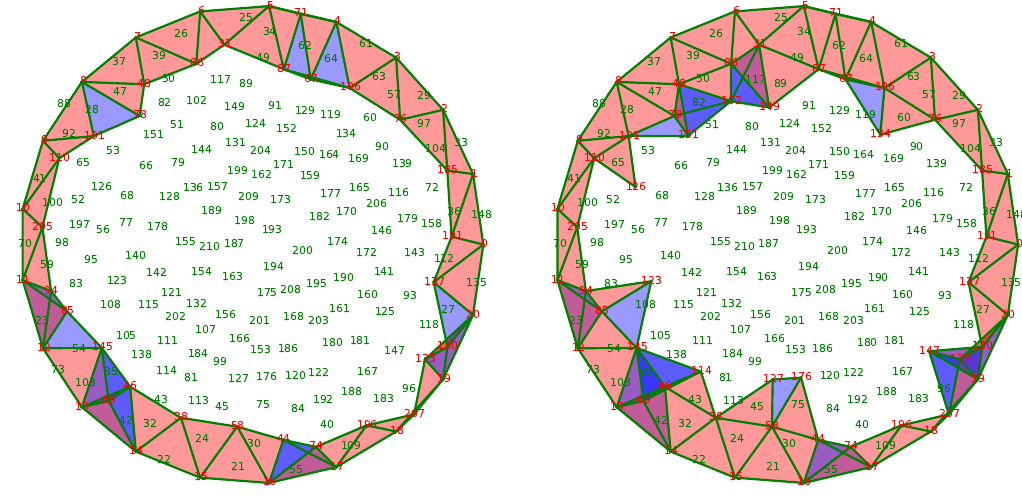
Figure 12. Steps of the first